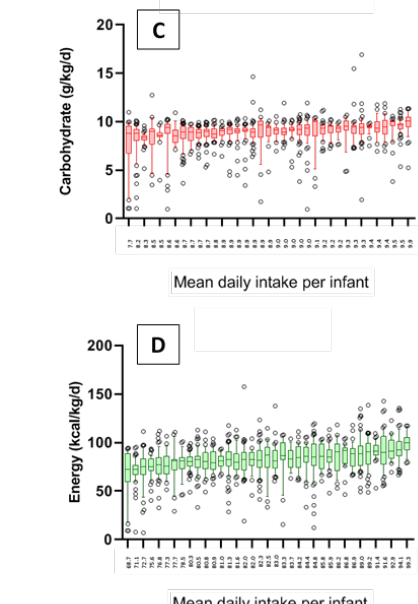
Table 2. Anthropometry and body composition outcomes at term equivalent age ( n = 37). Mean